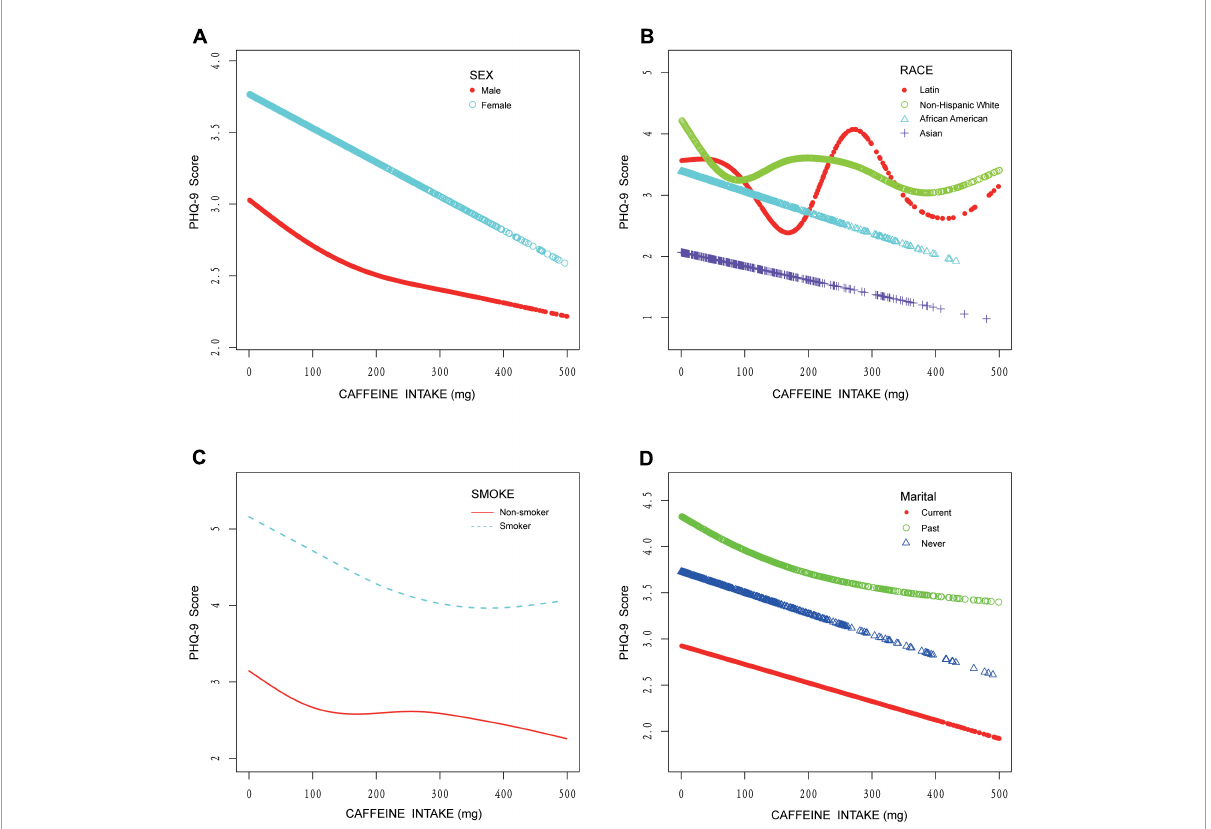
FIGURE3 Curve fitting model on the association between caffeine intake and depression stratified by sex, race, cigarette smoking, and marital status. (A) Stratified by sex. (B) Stratified by race. (C) Stratified by cigarette smoking. (D) Stratified by marital